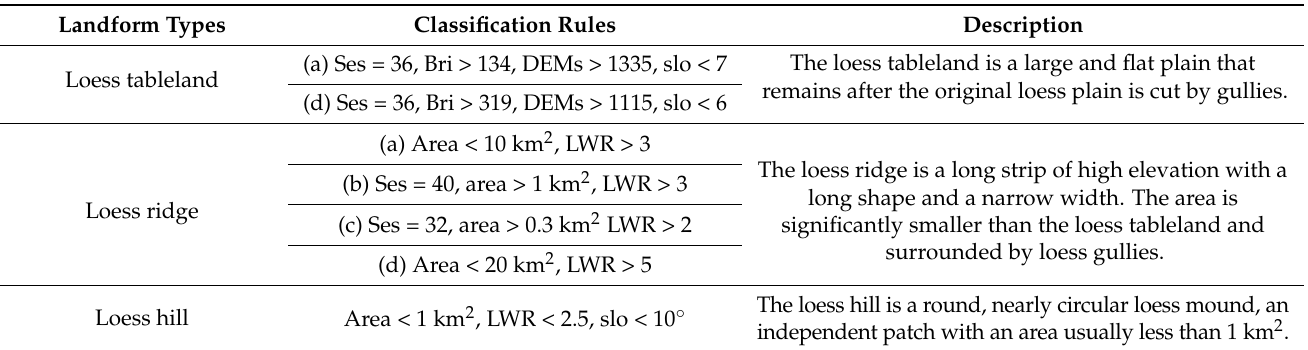
Table 3. Loess landform classification rule set.